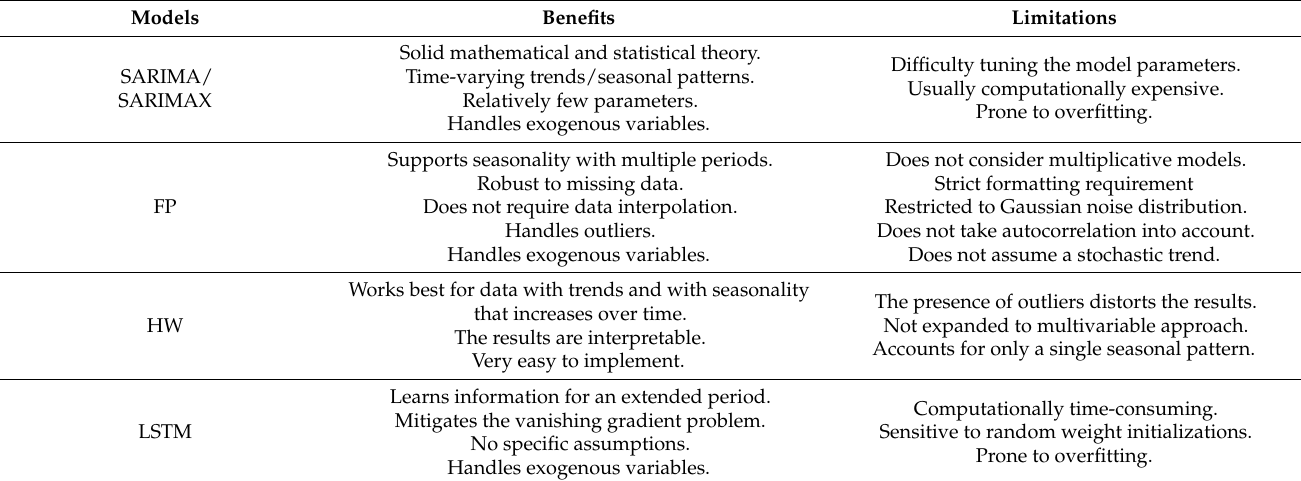
Table 1. Benefits and limitations of selected forecasting models. Models Benefits